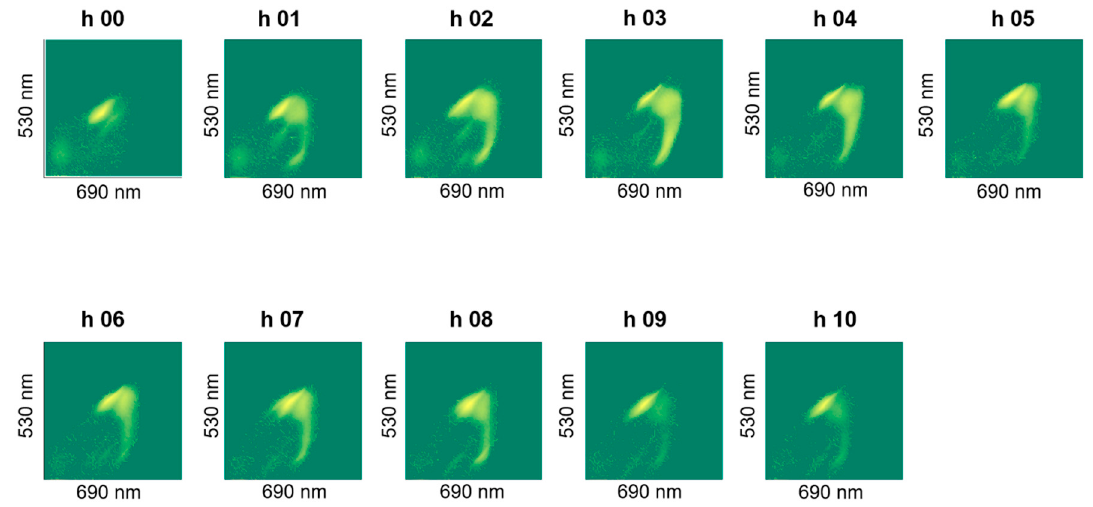
Figure A3. Plot of FL 1 against FL 2 fluorescence intensities of hourly samples showing dynamics of clusters observed during fermentation for pH-B (1) batch.